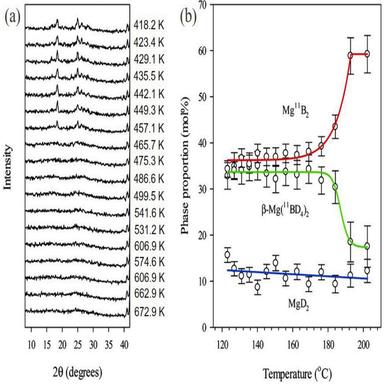
(a) In situ neutron diffraction patterns of β-Mg(11 BD4)2 at various temperatures during the cooling process from ca. 673–418 K, the strongest (101) reflection from unreacted Mg11 B2 is observed at ca. 2θ of 41°; (b) Evolvement of phase proportion with temperature showing crystallization of β-Mg(11 BD4)2 (QPA in (b)) below the polymorphic transition temperature.